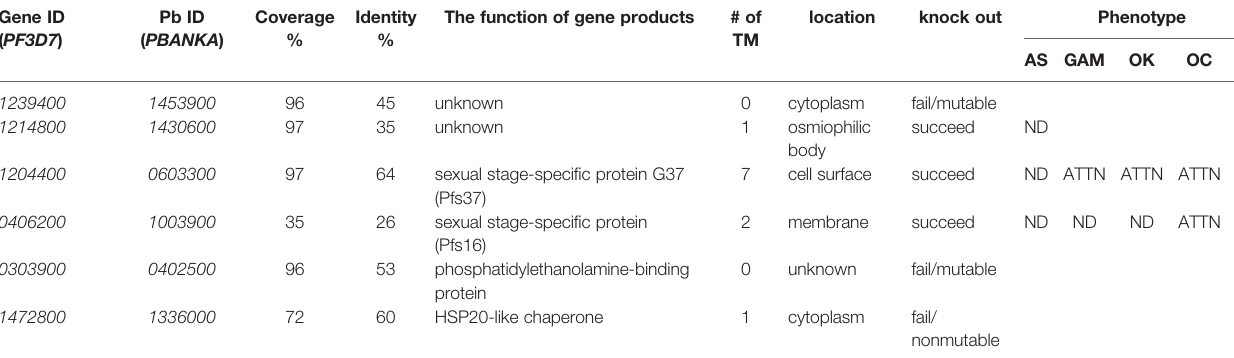
TABLE 2 | P . berghei phenotypes of candidate gene